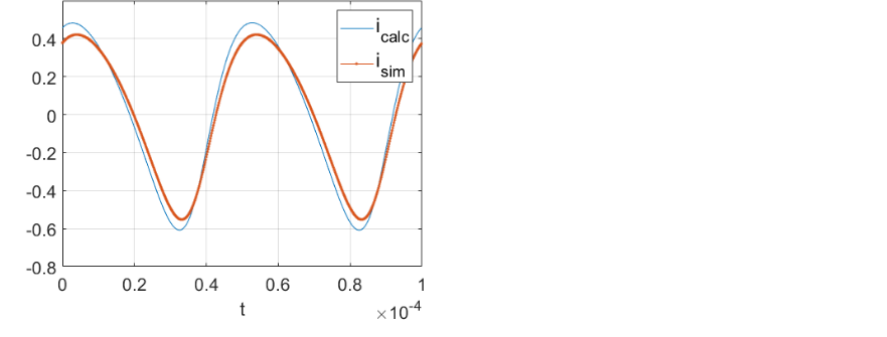
Figure 13. Waveforms of oscillator current in amperes for N = 600: i calc — from calculations and i sim — from simulation.